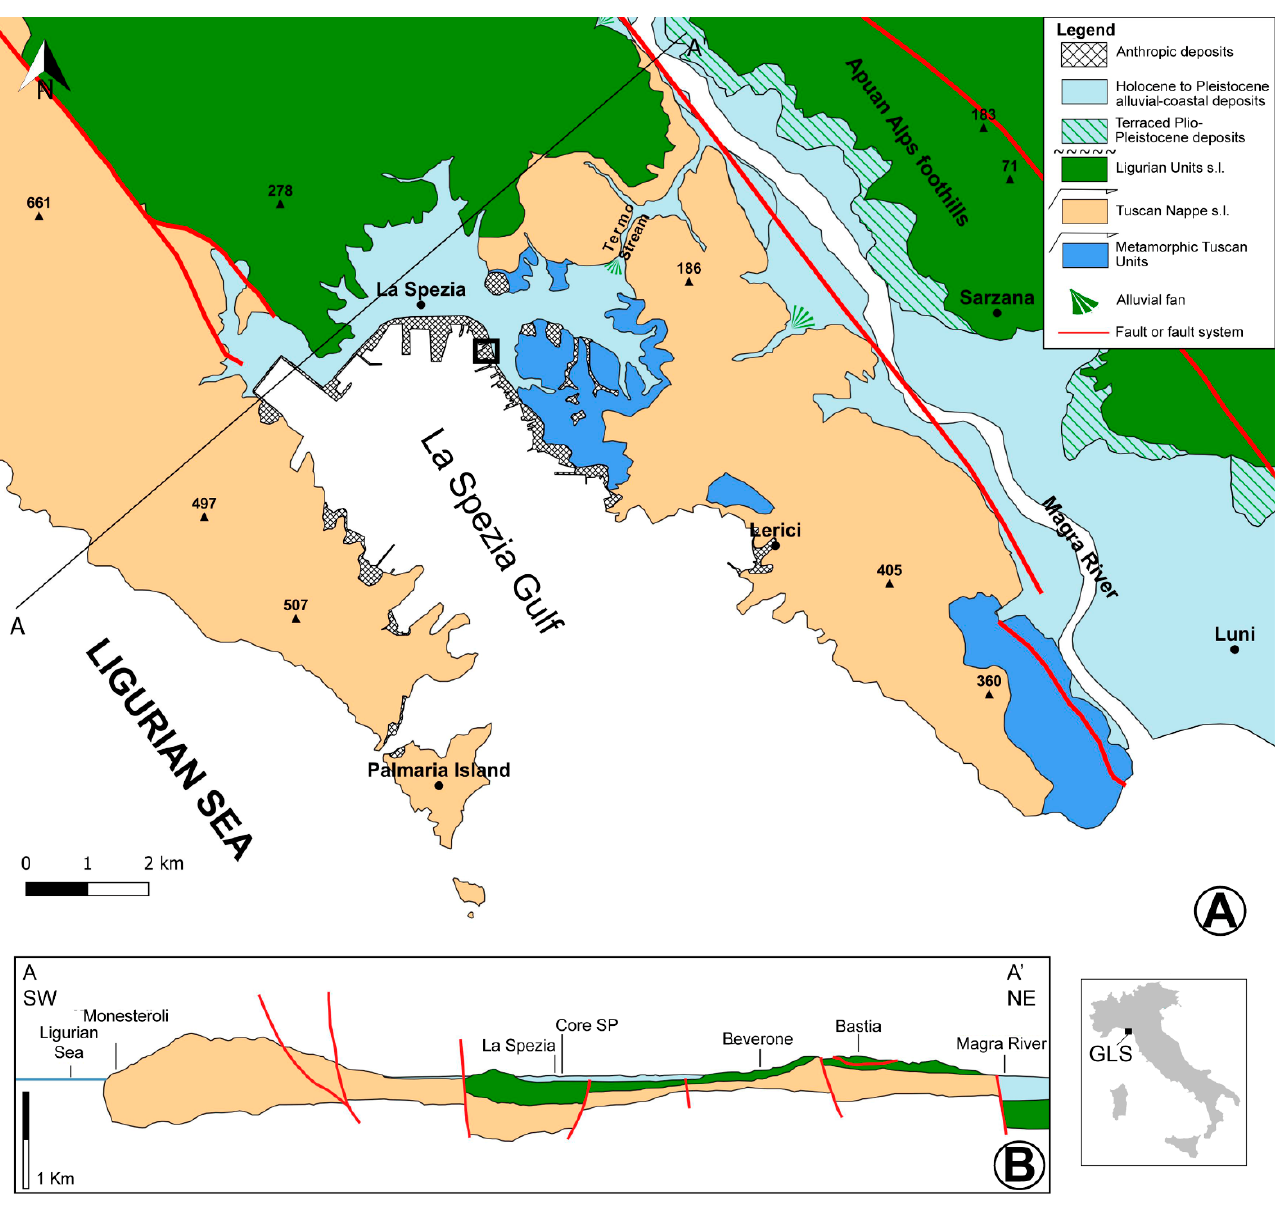
Figure 1. ( A ) Geological and geomorphological sketch map of the Gulf of La Spezia (GLS) and the surrounding areas; modified from Sheet 248–CARG Project and [21]. The inset shows the site of the coring campaign (see Figure 2). ( B ) Simplified geological cross-section modified from Sheet 248–CARG Project. Transect A-A’ is shown in Figure 1A. The location of the studied core SP is projected on the section.